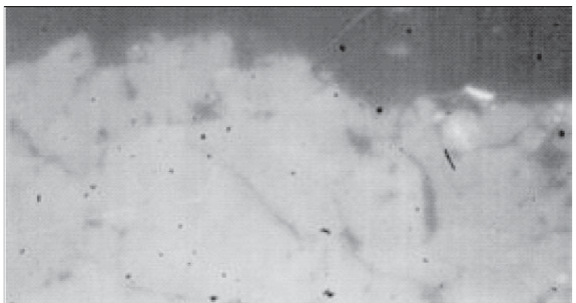
Figure 3. Cross section of a representative coating after erosion test. Cracks in the vertical (V) and parallel (P) direction are indi- cated.